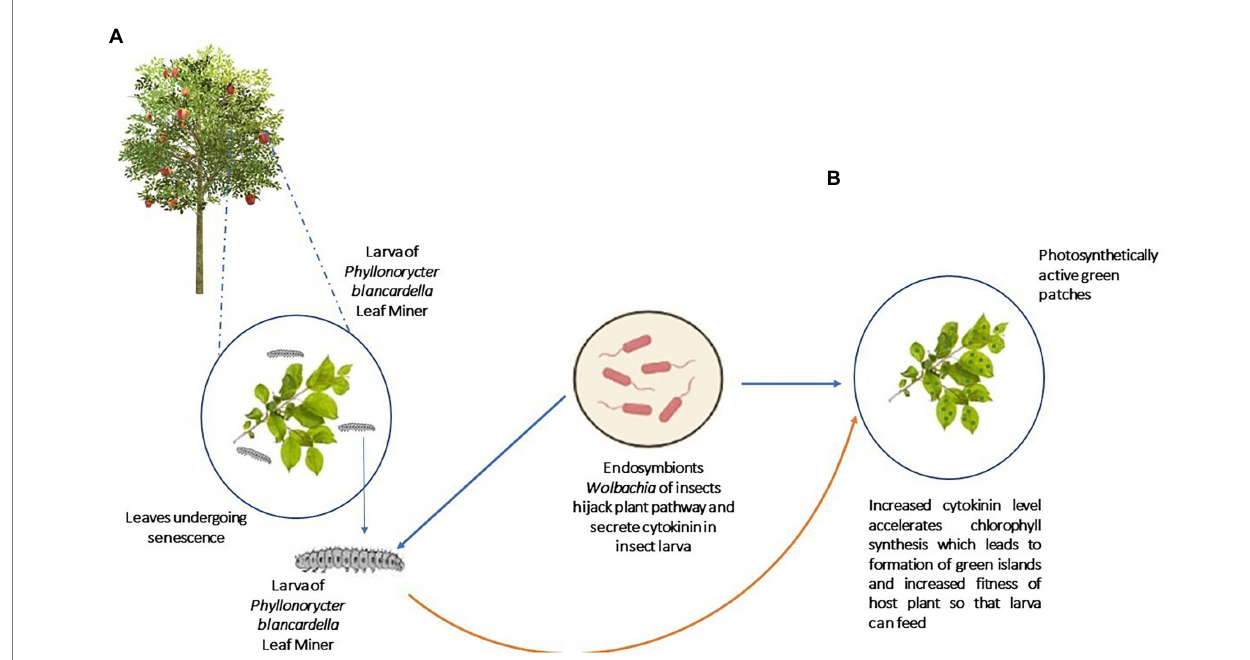
FIGURE 5 Hijack of plant pathway by symbionts: Gut symbionts of leaf miner Phyllonorycter blancardella can mimic the plant pathways where it secretes cytokinins and fools the plant resulting in chlorophyll production. (A) Before infestation by Phyllonorycter blancardella , (B) After infestation by Phyllonorycter blancardella (Production of green islands of chlorophylls as patches; Kaiser et al., 2010; Body et al.,